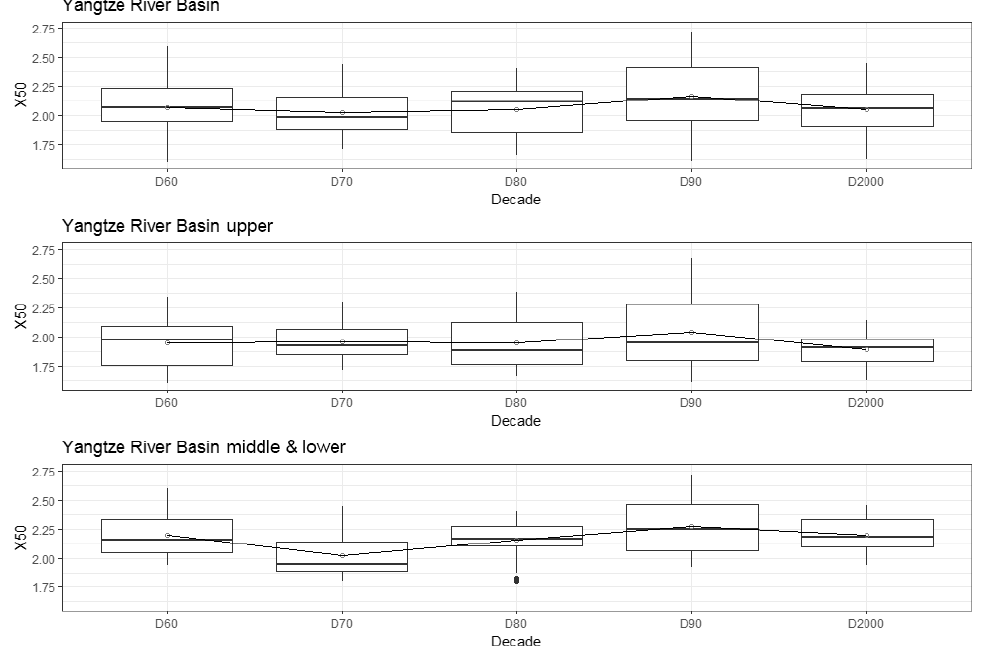
Figure 3. Variation of X50 with decades from each individual stations’ pooling group.